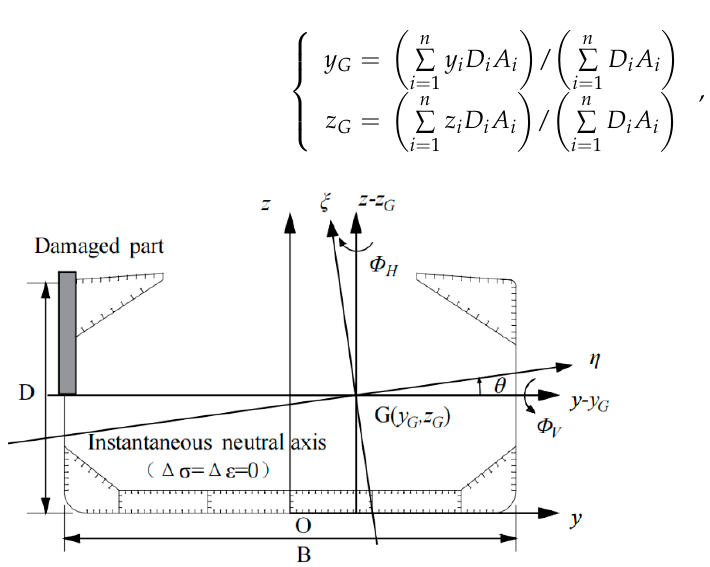
Figure 7. Schemes follow the same formatting.